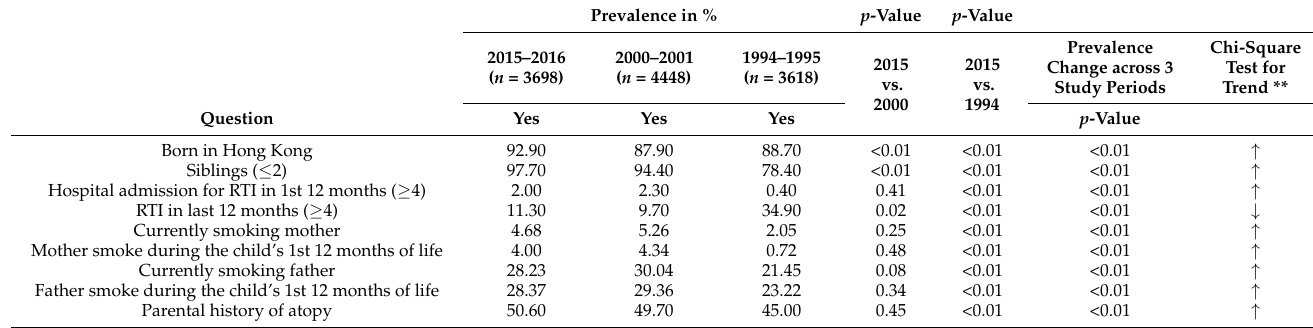
Table 2. Prevalence of potential risk factors with significant change across 3 study